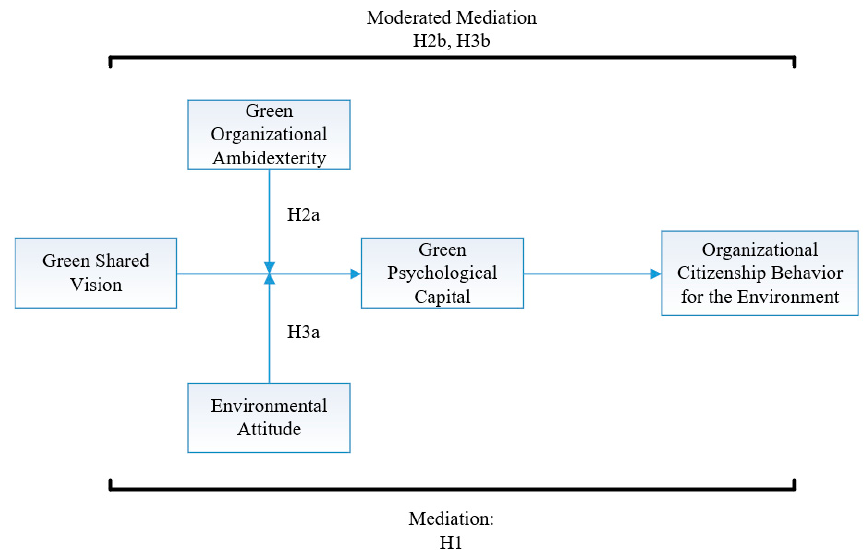
Figure 1. Theoretical model.